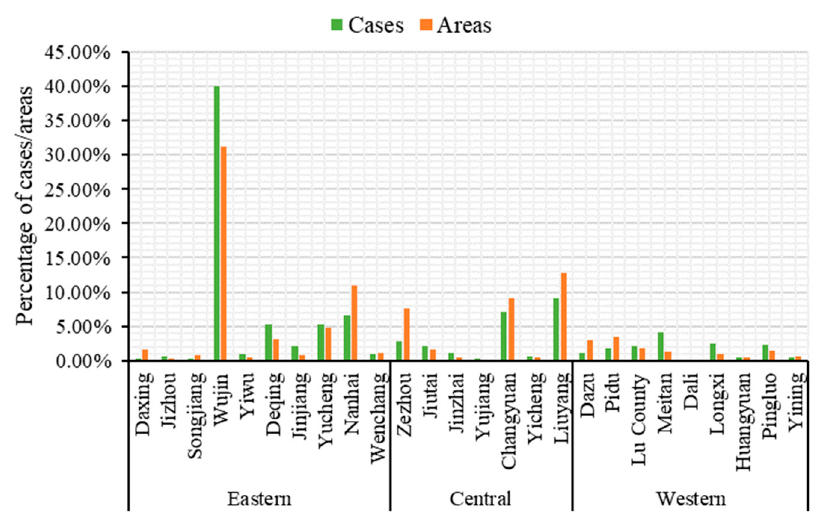
Figure 2. Percentage of cases and areas in 26 pilot areas.